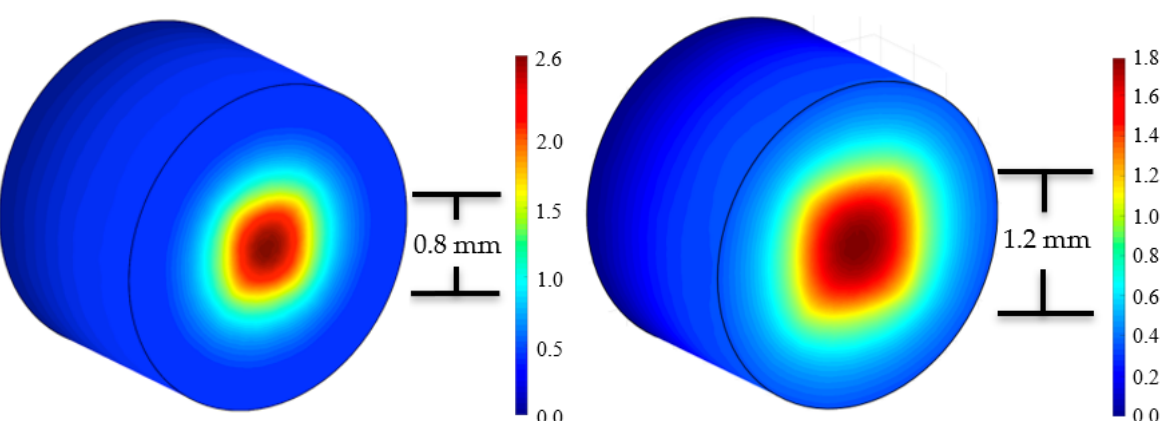
Figure 6. FEA simulation showing increase in the deformation area under compression applied to a central, square area. The figure on the left corresponds to compression with a central square of 0.8 by 0.8 mm in size, whereas the right figure shows compression with a 1.2 by 1.2 mm central square. Each simulation’s data was exported and used to calculate the resistance across the sensor. A parametric sweep of the surface area was simulated starting at a 0.8 by 0.8 mm square area and ending at a 2 by 2 mm square area.